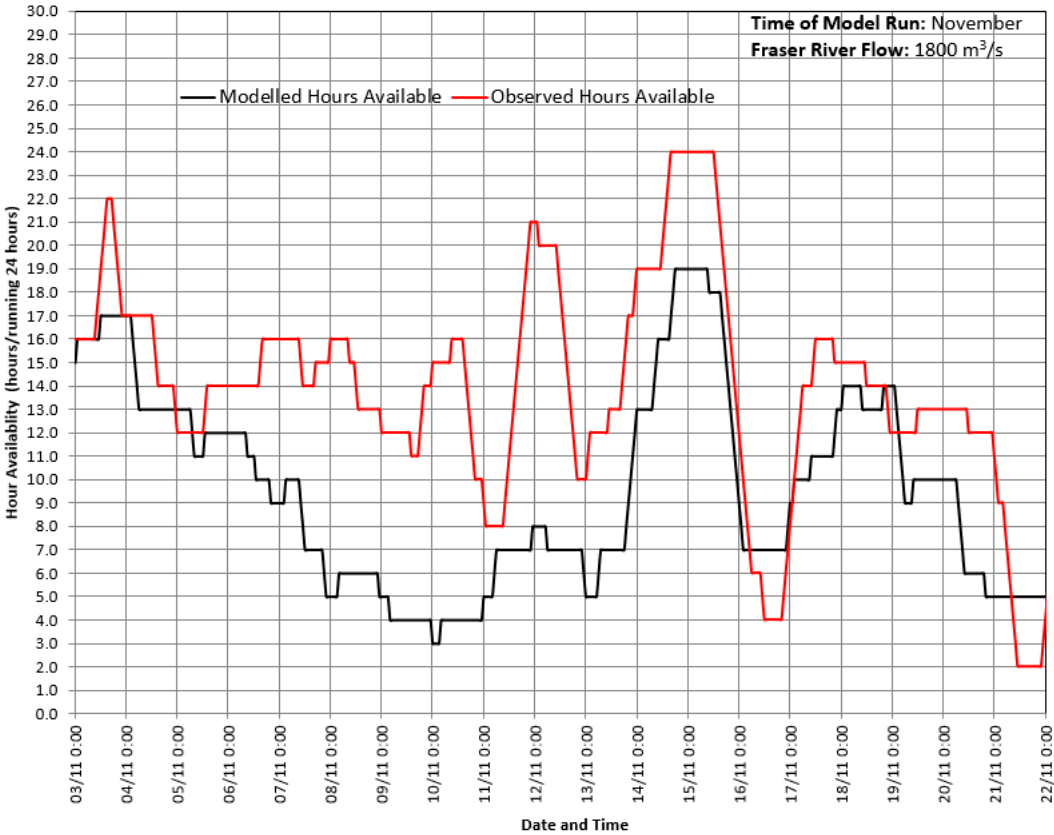
Figure 7. Comparison of observed and modelled available water withdrawal hours in November.